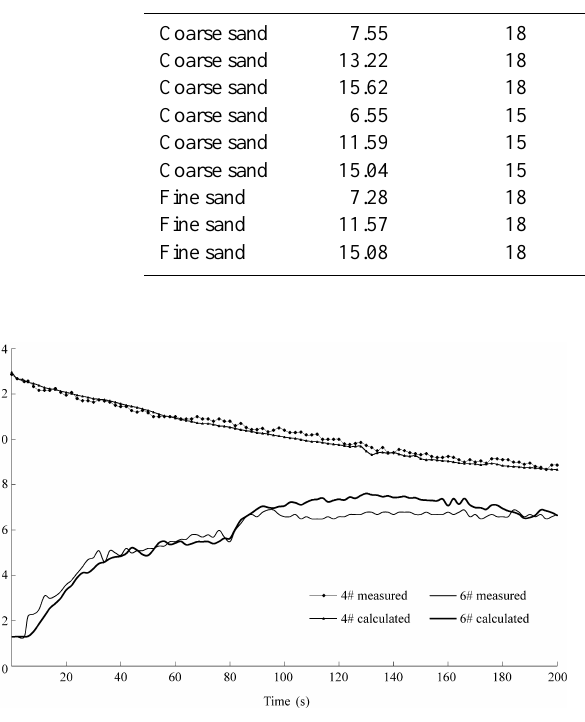
Fig. 6. Comparison between the calculated water level and actual water level.